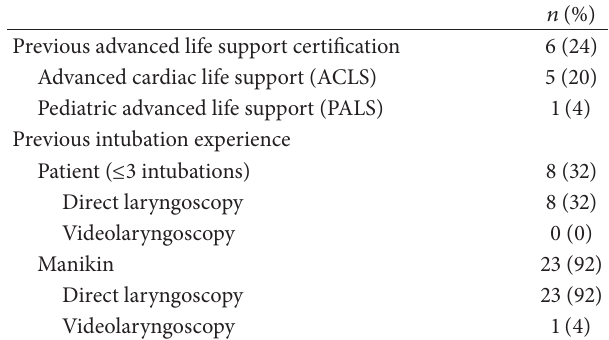
Table 1: Baseline characteristics of subjects ( 𝑁 = 25